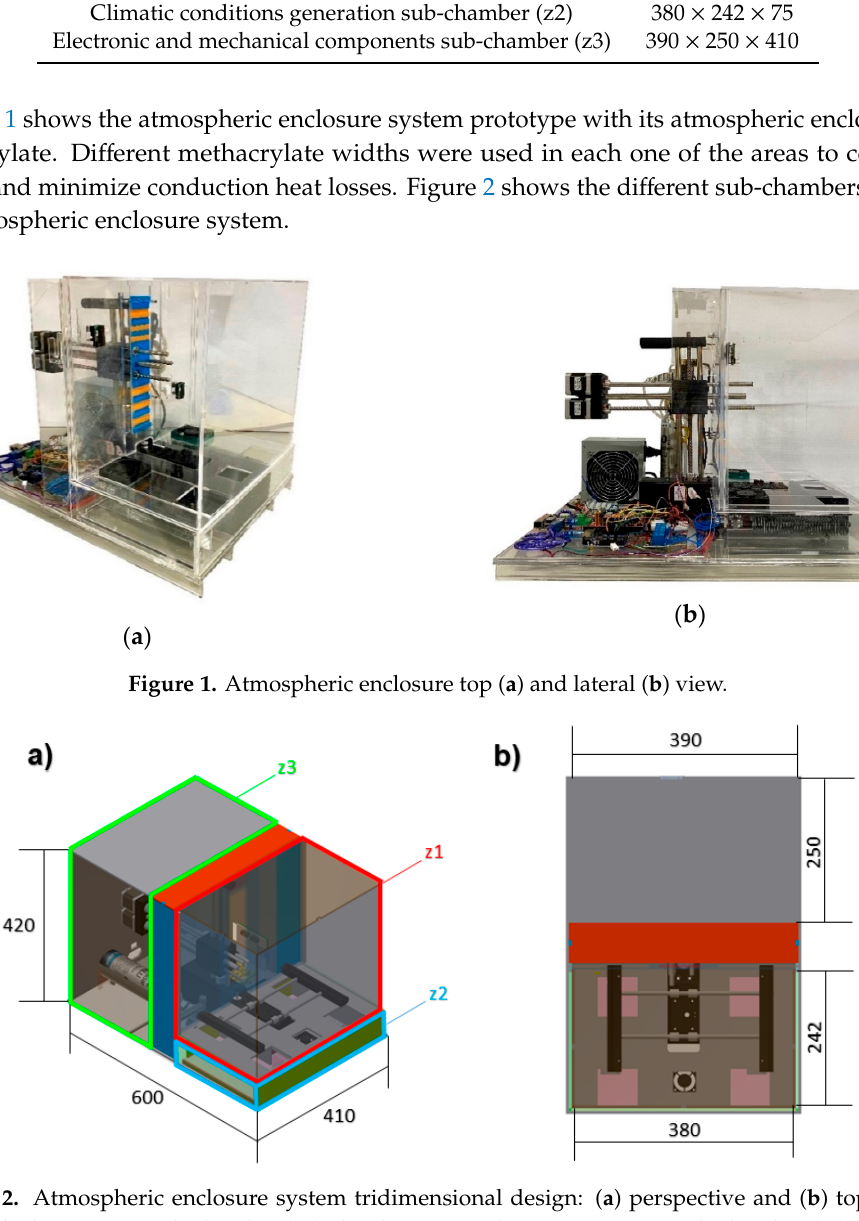
Figure 2. Atmospheric enclosure system tridimensional design: ( a ) perspective and ( b ) top view, where the bioprinting sub-chamber (z1), the climatic conditions generation sub-chamber (z2) and the electronic and mechanical components sub-chamber (z3) are located.